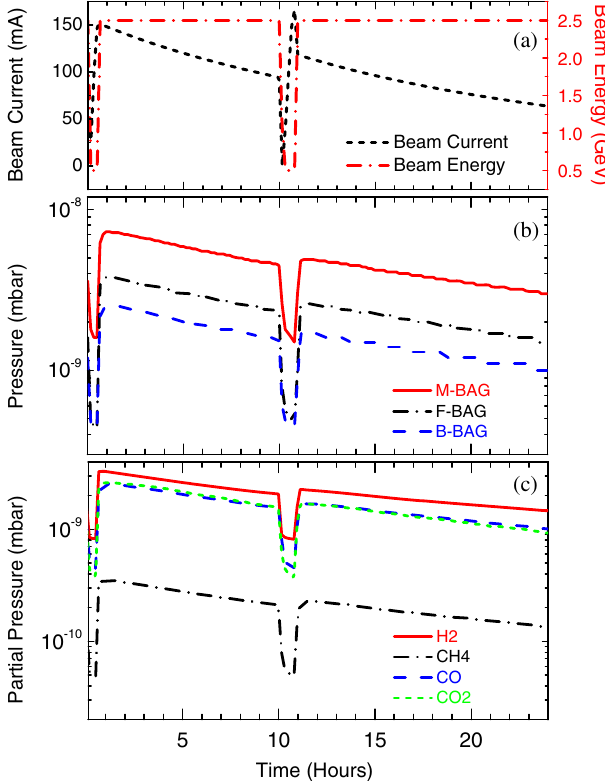
FIG. 9. Evolution as a function of time, during a 24 h KARA working cycle of (a) beam energy (red line) and beam current (black line), (b) pressure measured at the M-BAG (red line), F-BAG (black line), and B-BAG (blue line), and (c) partial pressures of H 2 (red line), CH 4 (black line), CO (blue line), and CO 2 (green line).